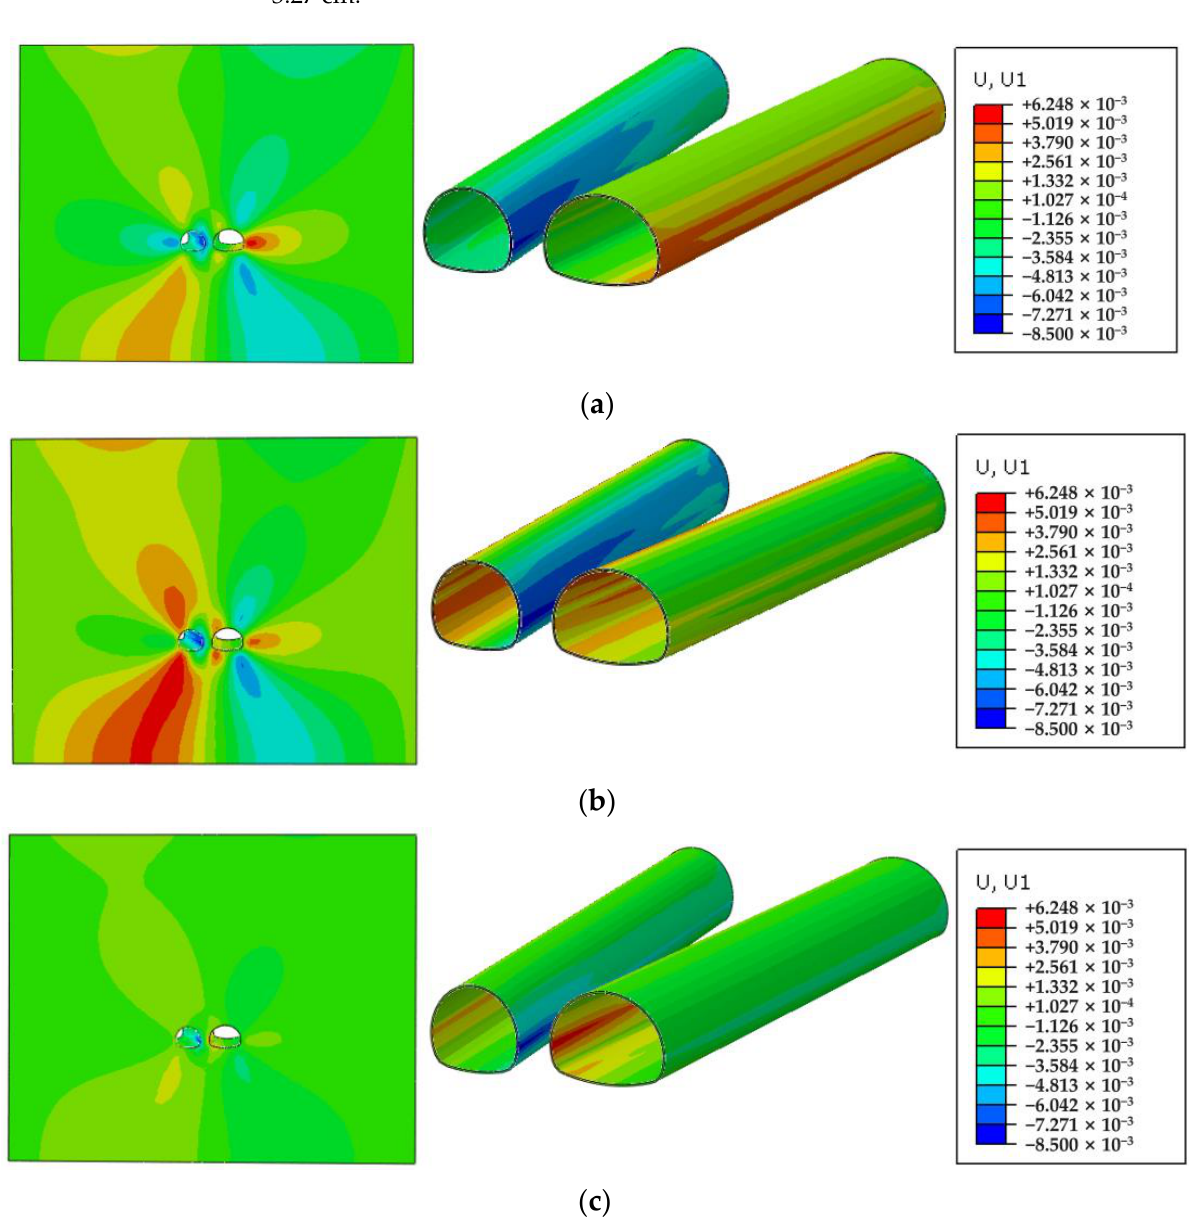
Figure 13. Horizontal displacement distribution of surrounding rock and lining after tunnel penetration: ( a ) Grade III rock mass; ( b ) Grade Ⅳ rock mass; ( c ) Grade Ⅴ rock mass.